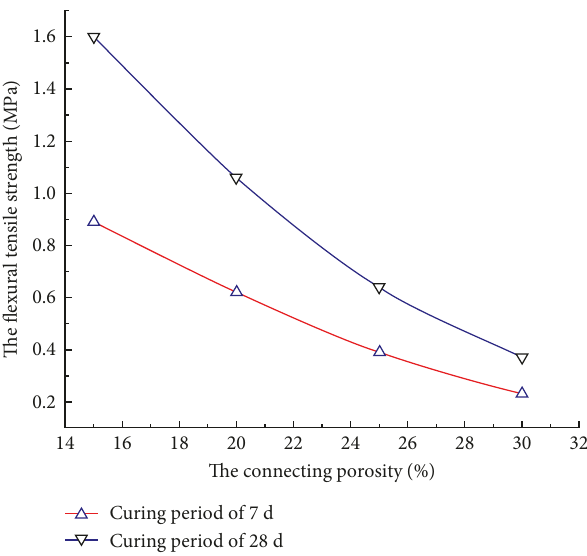
Figure 17: Relationship between connected porosity and flexural tensile strength.